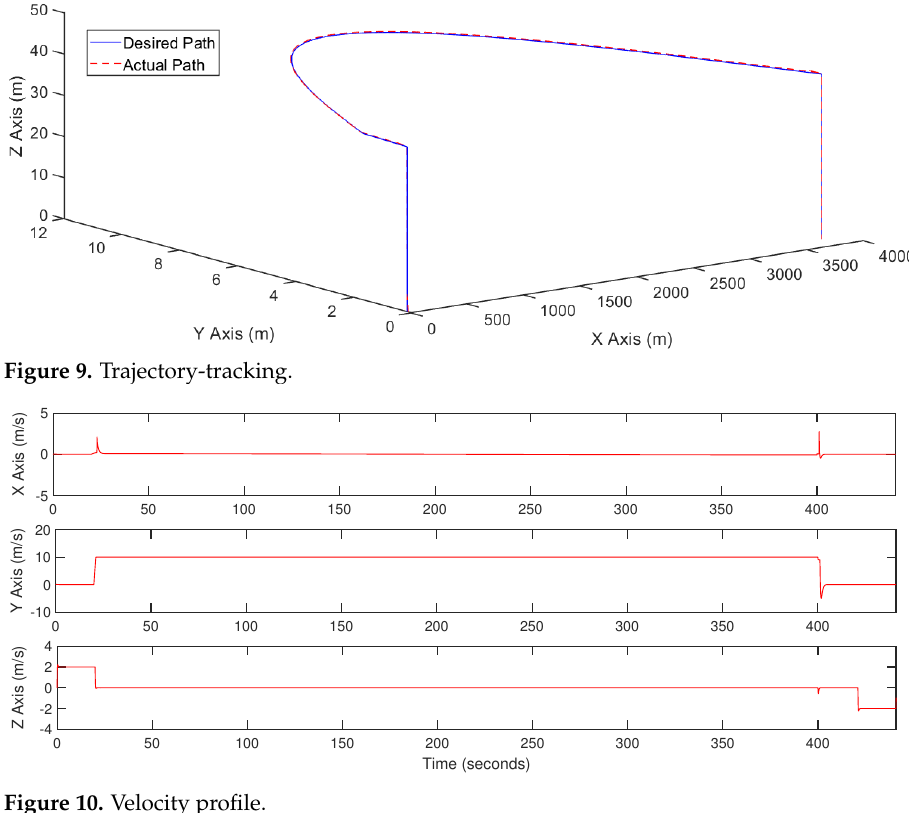
Figure 10. Velocity